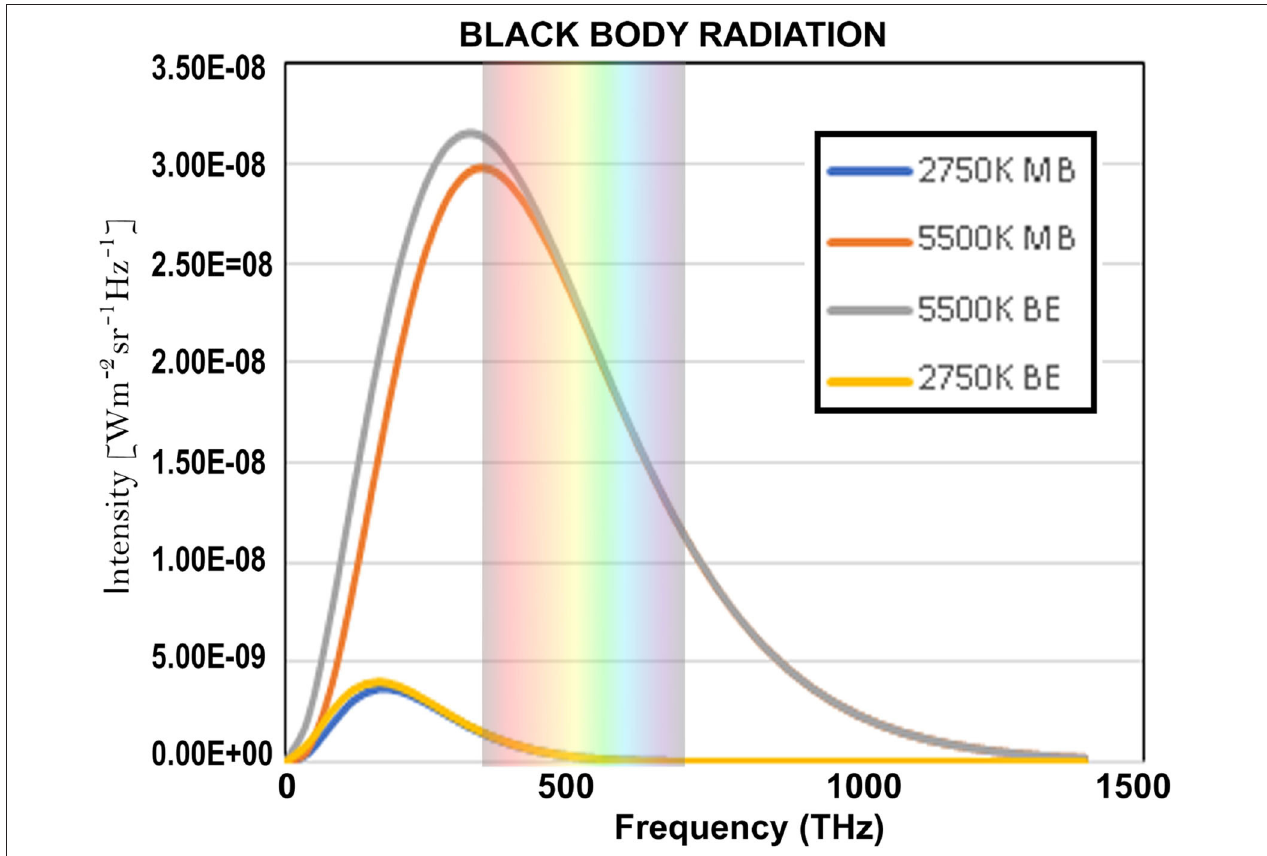
FIGURE 1 | The gray and yellow graphs are the Planck’s radiation law curves for 5500 ◦ Kelvin, which is approximately the temperature of the sun, and 2750 ◦ Kelvin, respectively, and the red and blue graphs are the Wien’s radiation law curves for 5500 ◦ Kelvin and 2750 ◦ Kelvin, respectively. We can clearly see on the graphs that for high frequencies, starting from red light, the two curves, the Wien curve and the Planck curve, practically coincide, and this was the reason that experiments were needed with low frequency electromagnetic waves to measure the difference between the